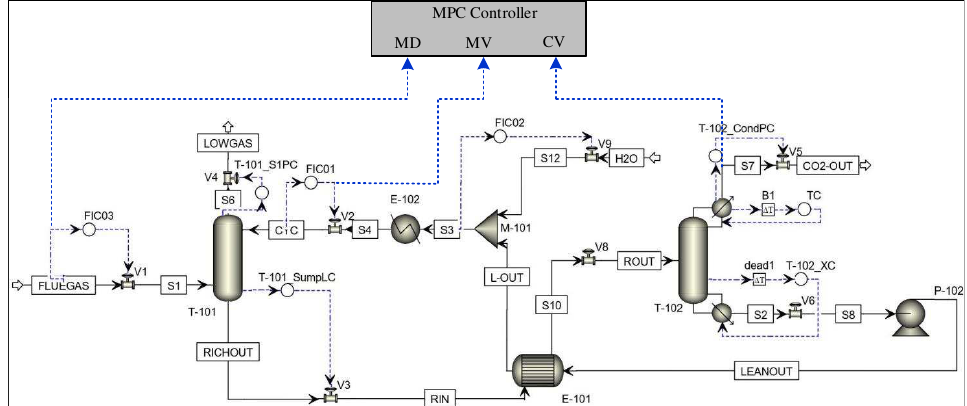
Figure 9. Schematic diagram of MPC control of the MEA-based post-combustion CO 2 capture process in Aspen Plus